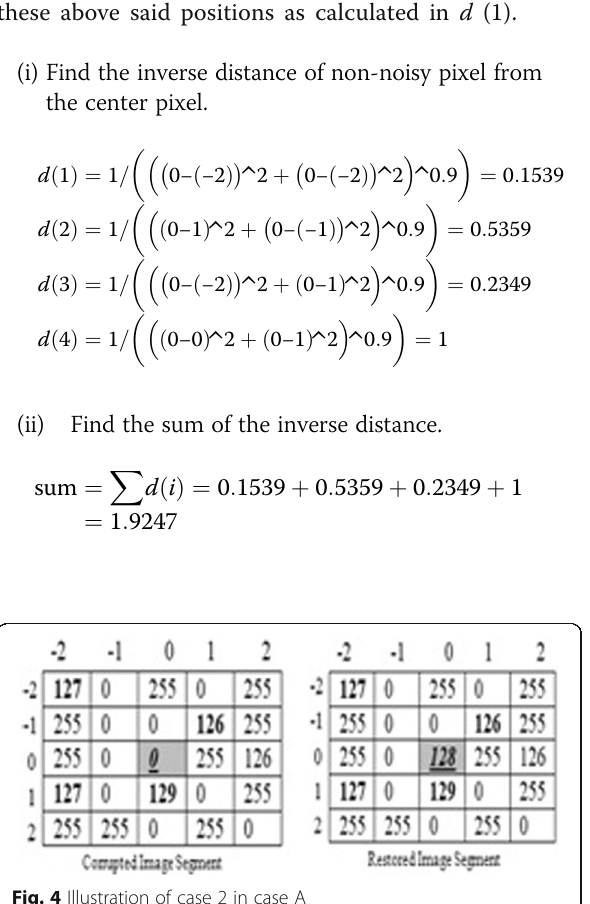
the current processing window is 2. So the window size was increased from 3 × 3 to 5 × 5 as shown in Fig. 4. The expanded window consists of four numbers of